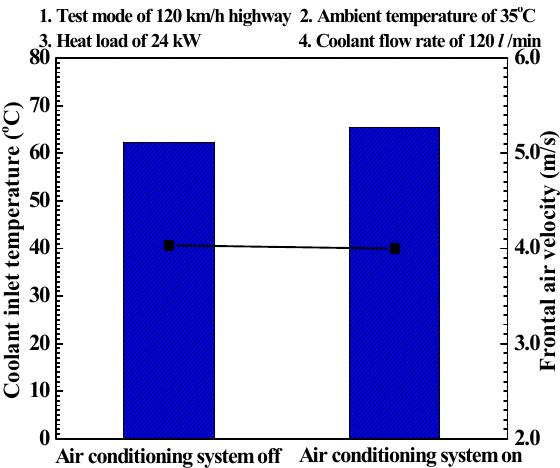
Figure 6. Cooling performance of the stack thermal management system with and without operation of the air ‐ conditioning system.